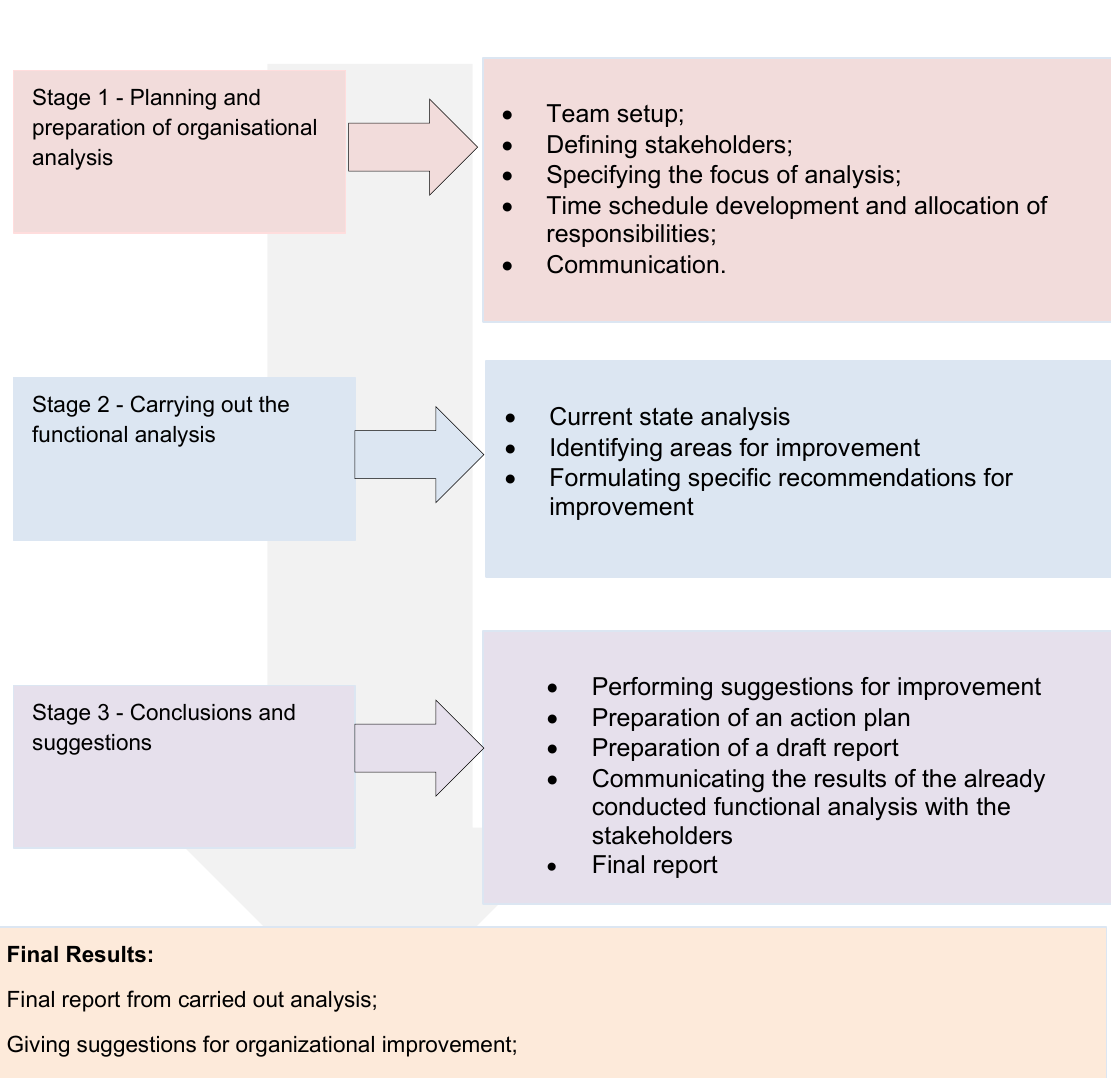
Figure 1: Planning and preparation of organisational